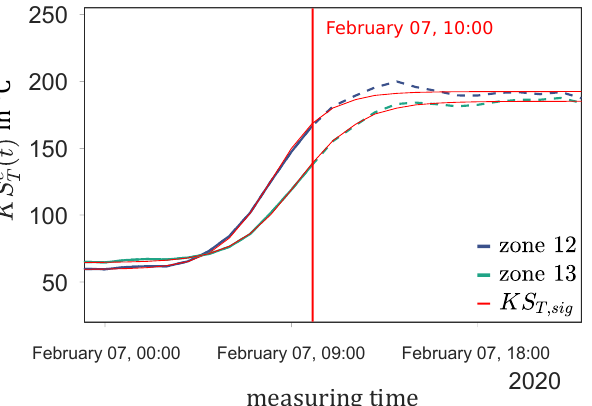
Figure 8. Results of the sigmoid estimation (red line) for a point in time during the melting process compared to the current and future temperature profile (dashed line).